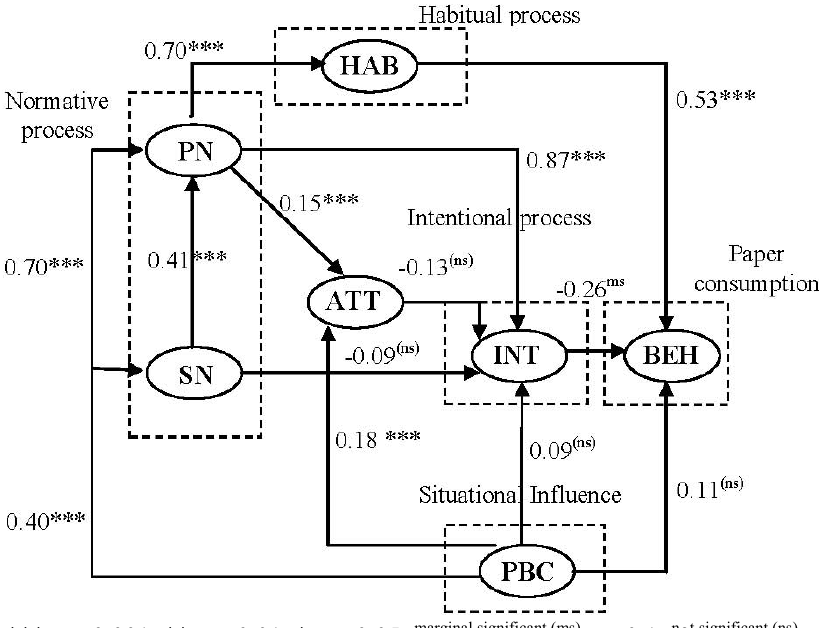
Figure 1. The tested theoretical framework to explain reducing paper consumption behavior. Standardized regression weights are displayed ( N =